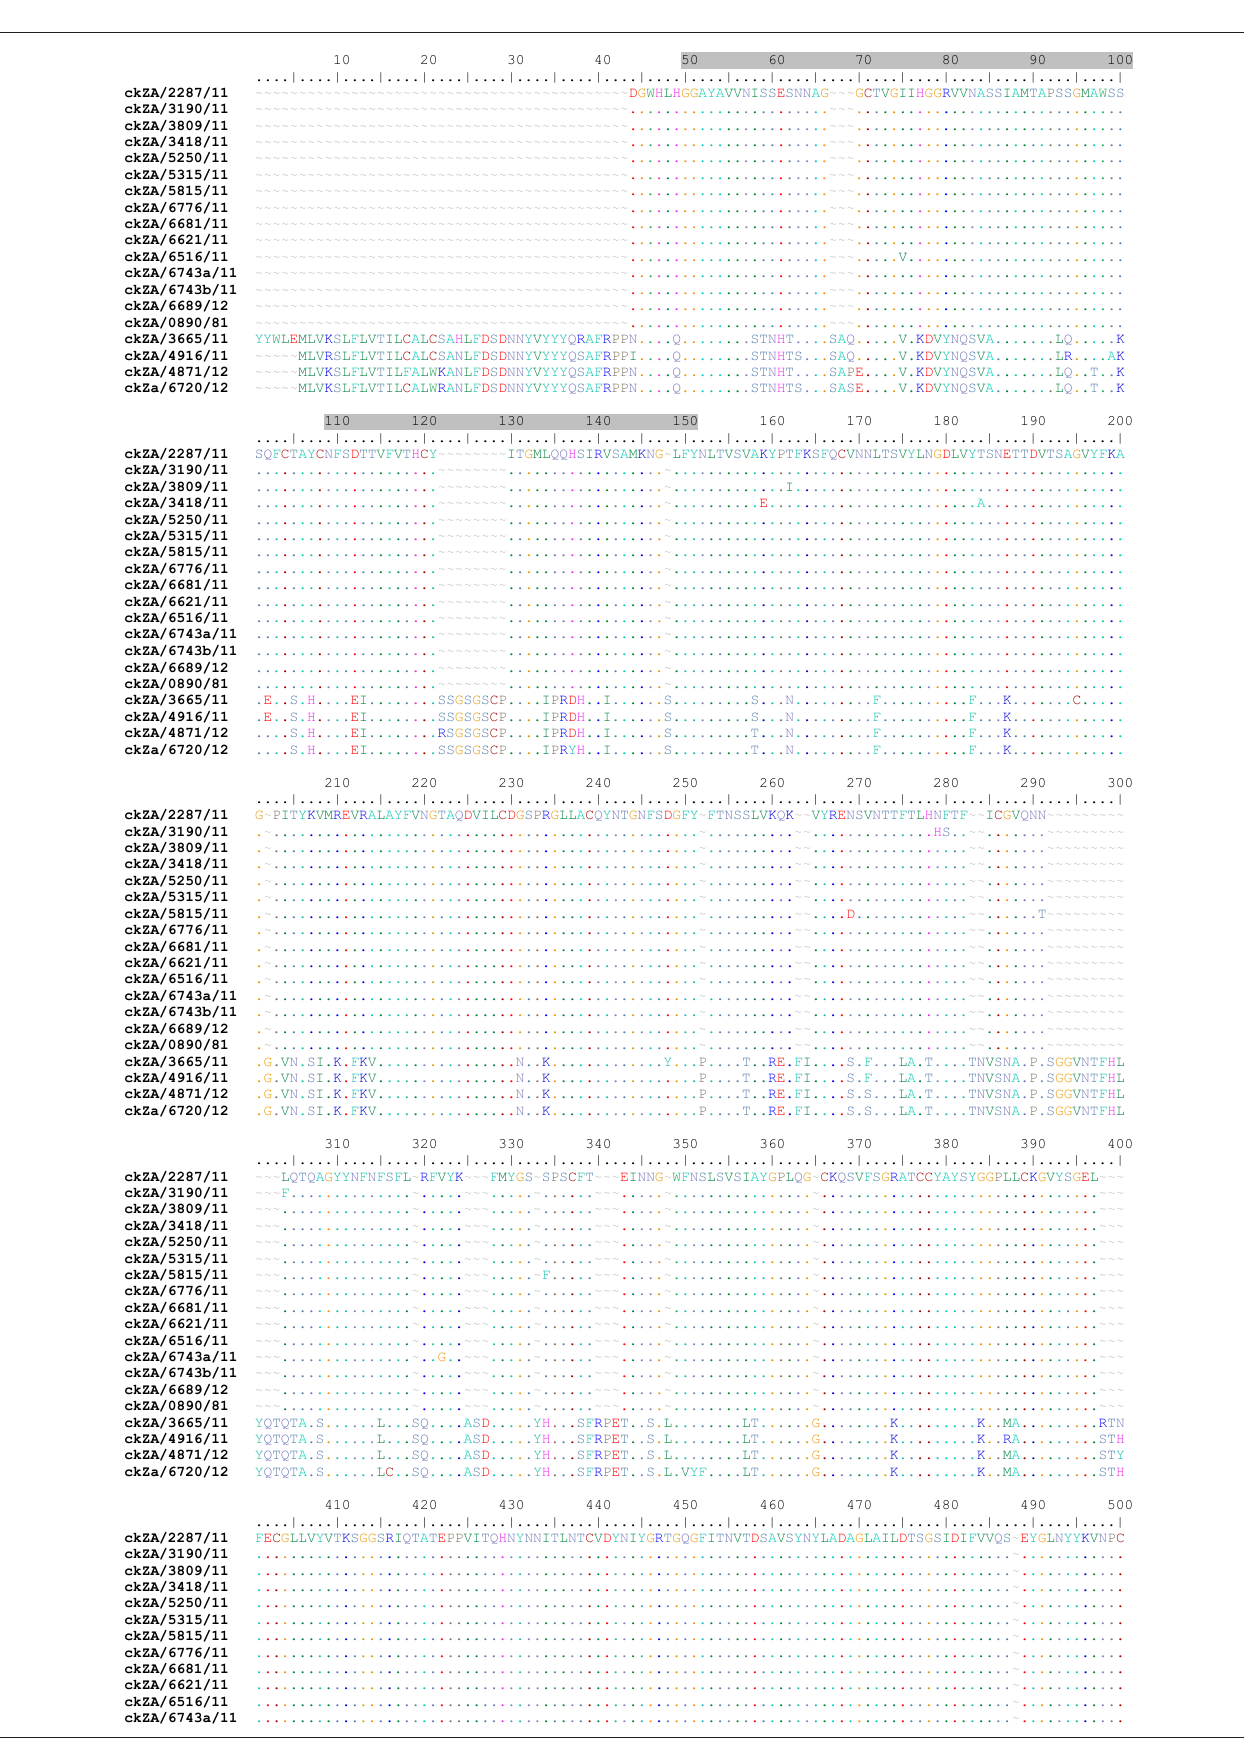
Figure 2 continues on next page